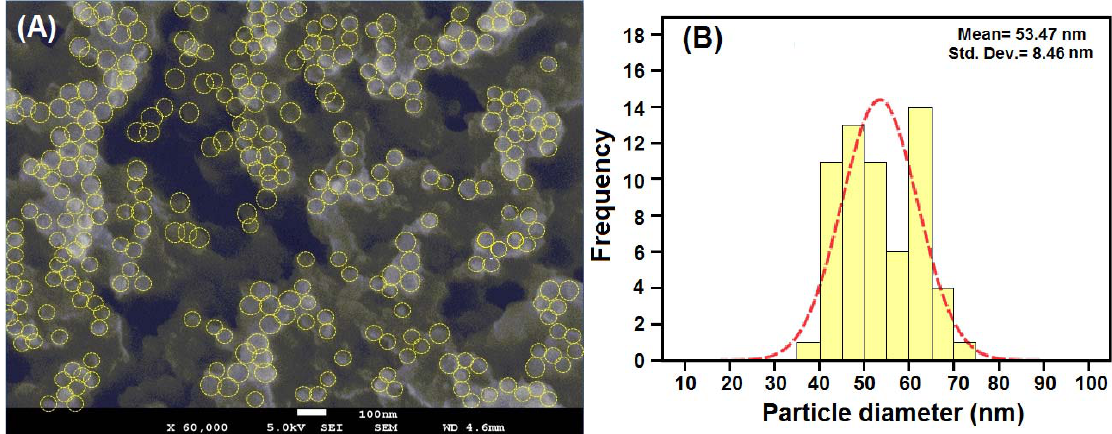
Figure 5. Image of Cu-NPs synthesized in 0.1% Cts media. ( A ) Histogram of embedded chitosan aggregated Cu-NPs distribution ( B ) at 100